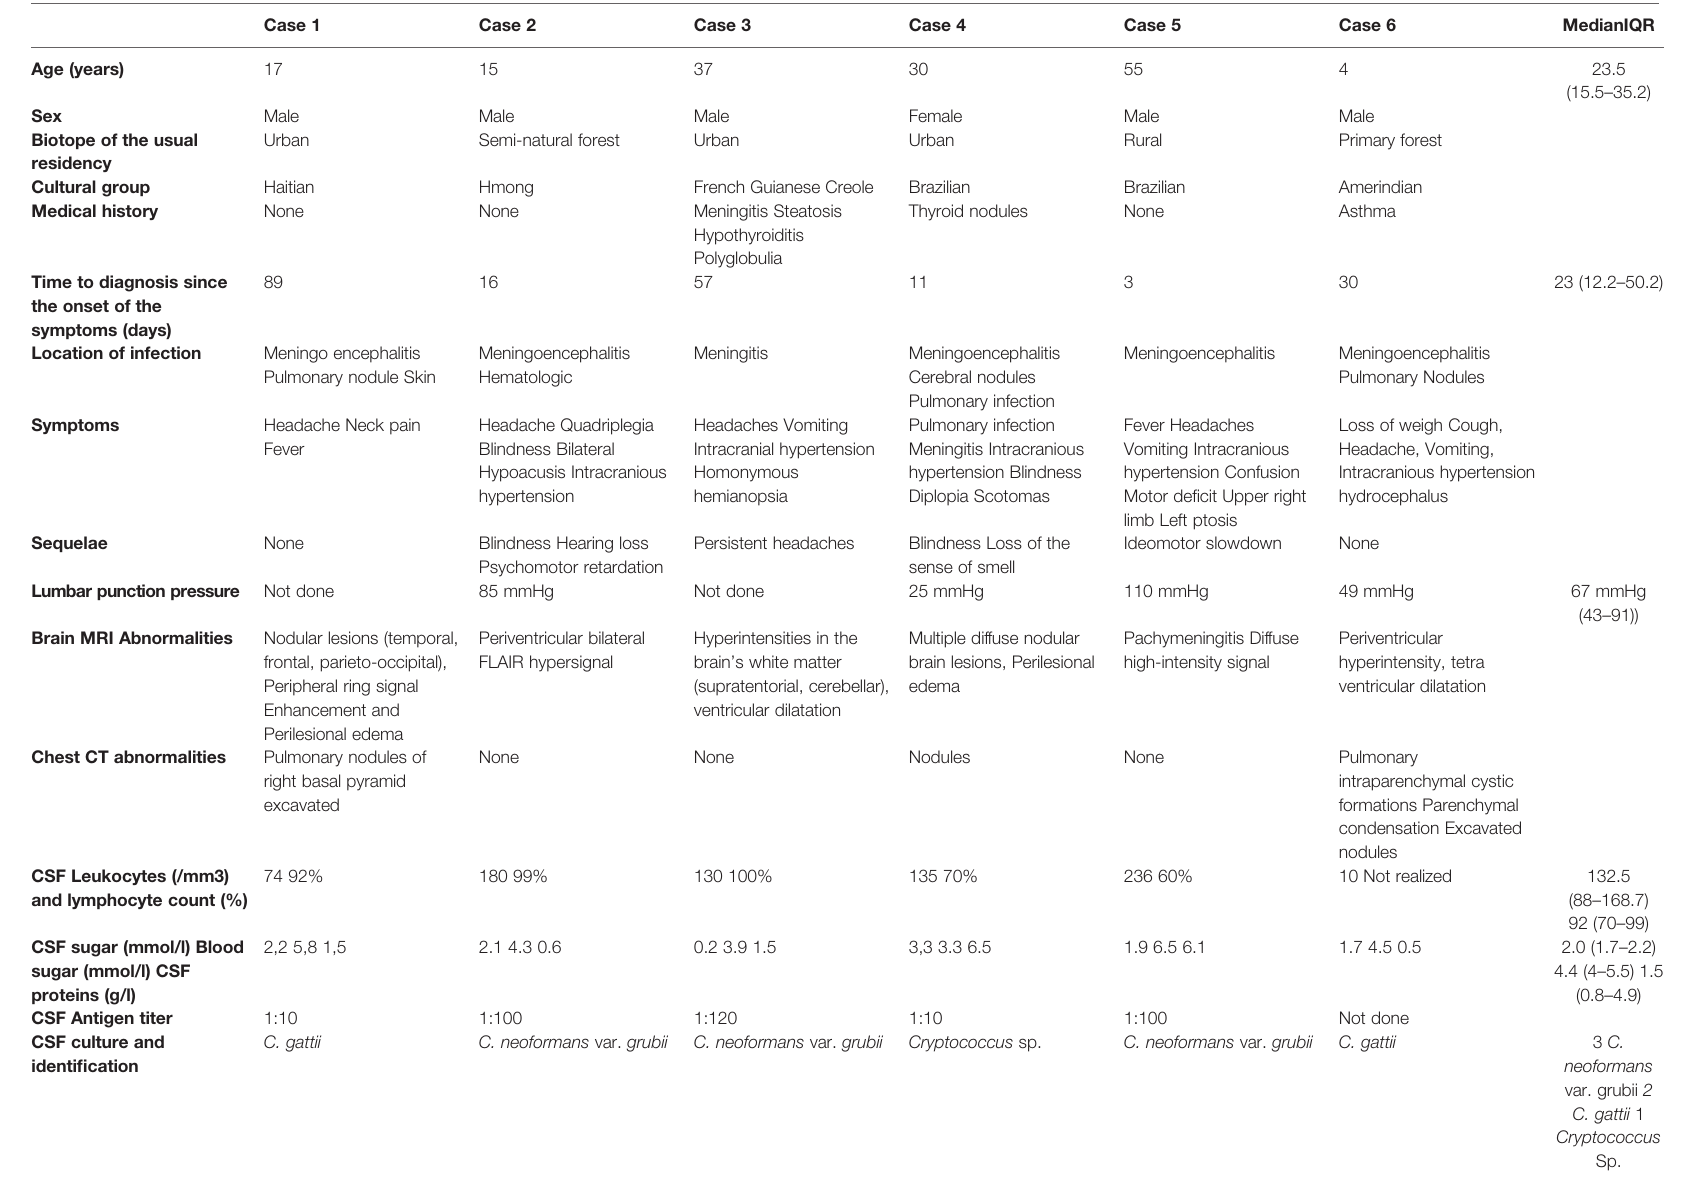
TABLE 1 | Clinical, epidemiological, fungal characteristics of the 6 Cryptococcosis